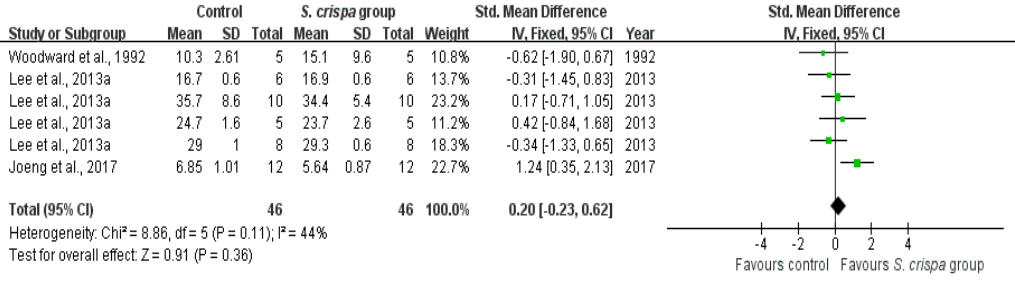
Figure 9. Comparison of the anti-fungal activity between control and S. crispa groups. ( ): SMD of individual studies; ( ): summary SMDs of the comparison.